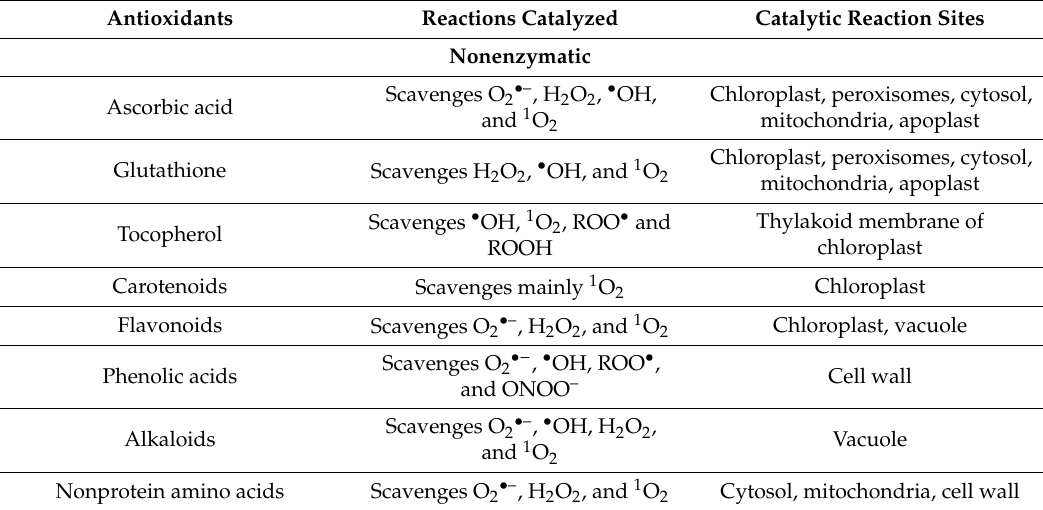
Table 2. Reaction mechanisms of major reactive oxygen species (ROS) scavenging enzymatic